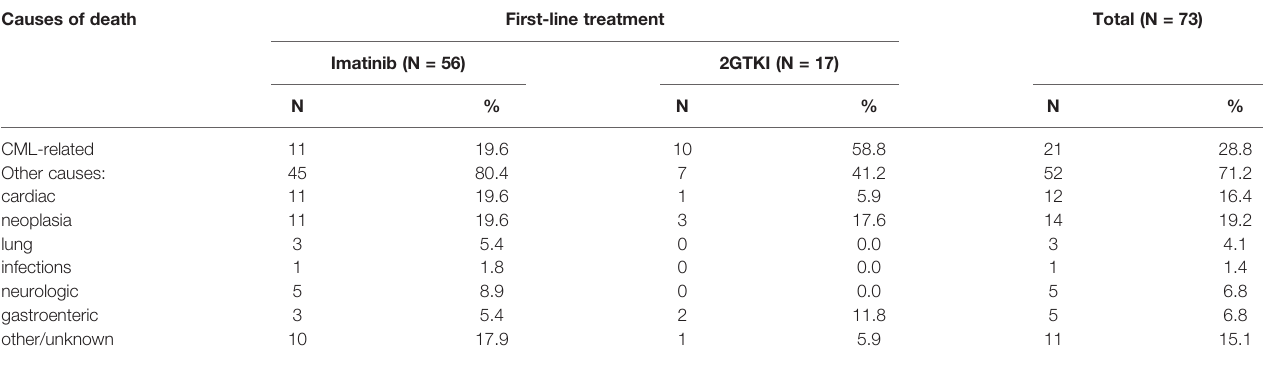
TABLE 2 | Causes of death of CML patients by front-line TKI treatment. Causes of death